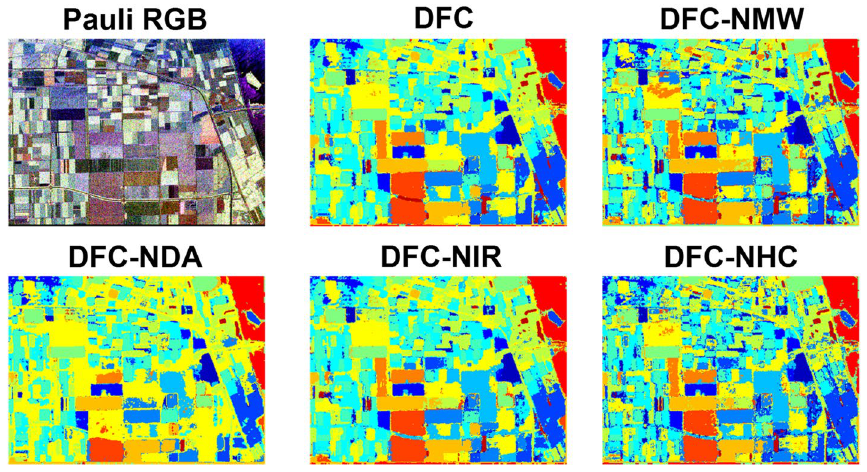
Figure 3. Pauli RGB and the achieved classification maps for Flevoland dataset.